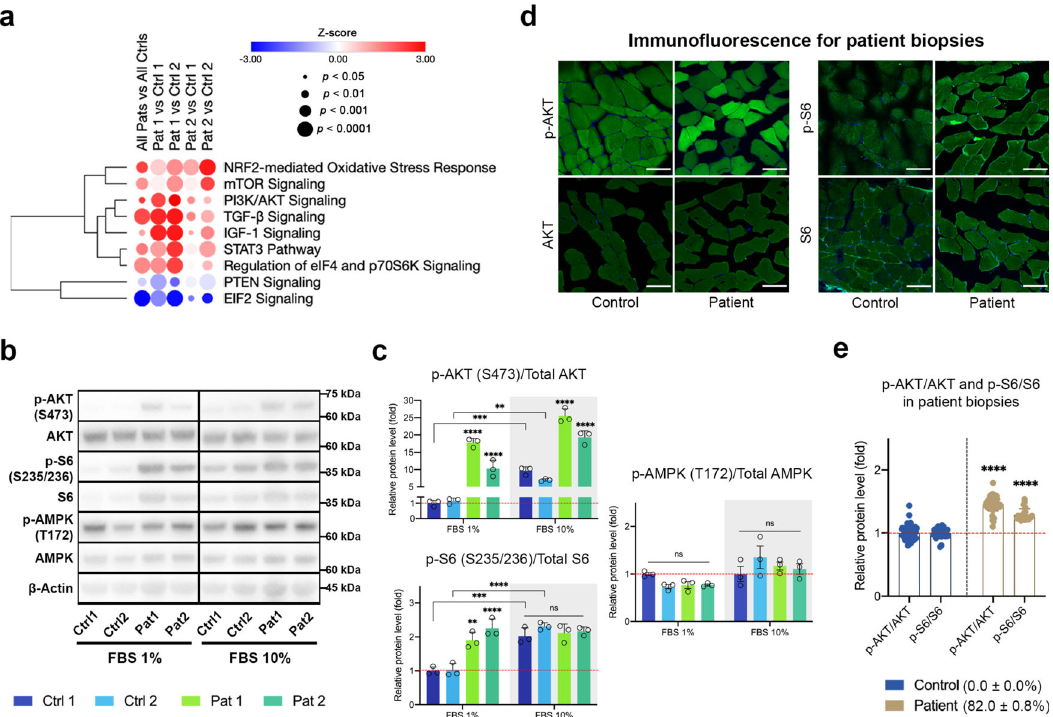
Fig. 4 The PI3K-Akt-mTORC1 axis is upregulated in the m.3243 A > G mutant cells. a Analysis of RNA-seq data from the patient fi broblasts by QIAGEN ingenuity pathway analysis (IPA) showed cell signalling pathways, which are enriched in cells carrying the m.3243 A > G mutation. These include striking and signi fi cant increases in the expression of pathways involving PI3K-Akt, mTOR, EIF2, and NRF2. It is notable also that PTEN expression, a negative regulator of PI3K-Akt-mTOR signalling was downregulated ( p < 0.05). b , c Immunoblotting of p-Akt (S473)/Akt, p-S6 (S235/236)/S6 and p-AMPK (T172)/AMPK in patient fi broblasts grown in the presence of 10 or 1% FBS media ( b ), showing a major increase in p-Akt/Akt ( p < 0.0001) and p-S6/S6 ( p < 0.0001) in the presence of 1% FBS media in the mutant cells; in contrast, there is no difference in p-AMPK/AMPK ( c ; n = 3 independent experiments). d , e Immuno fl uorescence staining for p-Akt (S473)/Akt ( n = 66 and 78 muscle fi bres for Control and Patient, respectively; p < 0.0001) and p-S6 (S235/ 236)/S6 ( n = 30 and 23 muscle fi bres for Control and Patient, respectively; p < 0.0001) in patient muscle biopsies ( d ) con fi rmed the increased Fig. 4a, are represented as mean ± SD and were analysed by one-way ANOVA with Tukey ’ s multiple comparisons test for fi broblasts and by unpaired t -test for biopsies (* p < 0.05, ** p < 0.01, *** p < 0.001, **** p <